Question: Provide a one-line summary of what is displayed.
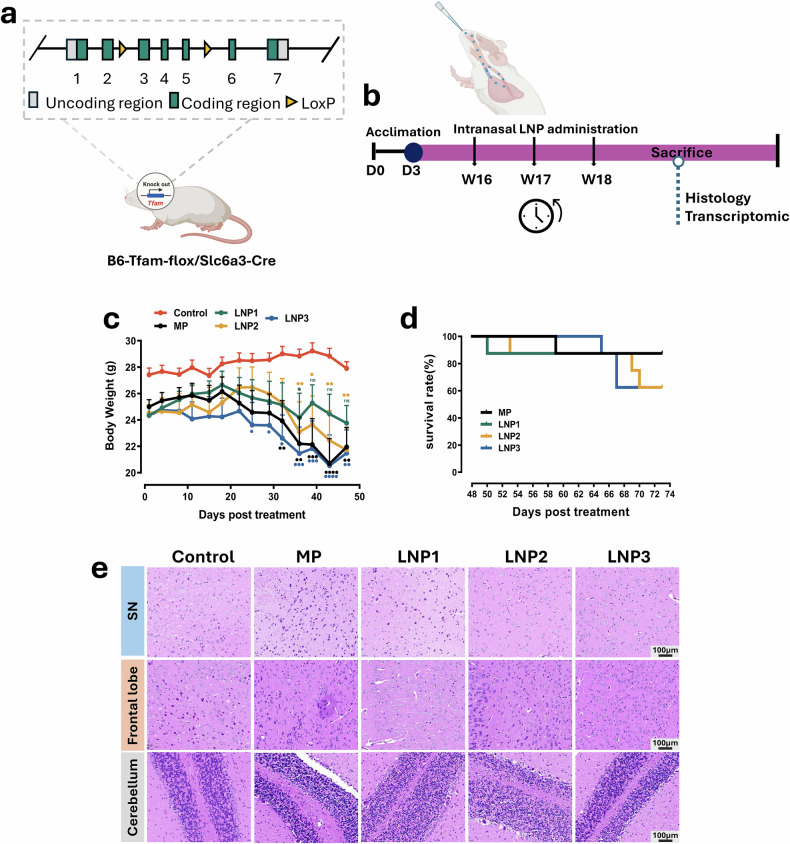
Answer: In vivo survival data (body weight and Kaplan‒Meier) and histology (H&E) results for the therapeutic PUFA-enriched lipid nanoassemblies (LNP1, LNP2, and LNP3). The survival and body weight changes in the B6-Tfam-flox/Slc6a3-Cre-MP mouse model (MitoPark) after intranasal LNP treatment. a The MitoPark model (MP) was generated by crossing B6-Tfam-flox mice with Slc6a3-Cre drivers, resulting in targeted deletion of mitochondrial transcription factor A ( Tfam ) in dopaminergic neurons. 7 , 8 , 60 a , b Schematic representation of the conditional knockout strategy targeting Tfam in dopaminergic neurons and the experimental workflow, including intranasal administration of LNP formulations (LNP1, LNP2, LNP3). c , d Body weight measurements and Kaplan‒Meier survival analysis of WT control, MP (MitoPark disease state), and LNP-treated MP mice showing progressive weight loss, accompanied by reduced survival compared with that of control mice. The results are reported as the mean ± SD ( n = 8; * p < 0.05, **p < 0.01, *** p < 0.001, **** p < 0.0001). Statistical differences were determined using two-way ANOVA followed by Dunnett’s multiple comparisons test. e H&E staining of frontal lobe, cerebellum, and substantia nigra (SN) tissues from the B6-Tfam-flox/Slc6a3-Cre MP mouse model showing histopathological alterations in MP mice compared with those in control and LNP-treated mice (scale bar is 100 μm)